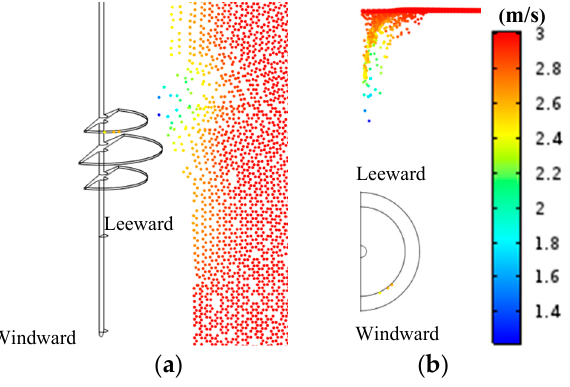
Figure 4. The map of contamination particles movement position from ( a ) aerial view and ( b ) top view after being released for 0.4 s.